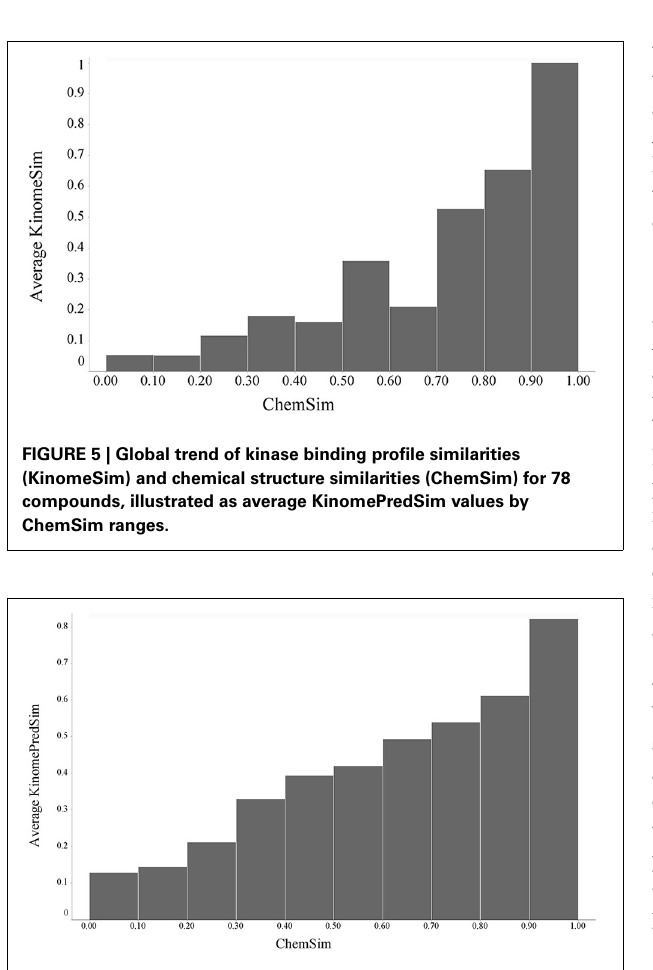
FIGURE 6 | Global trend of pairwise predicted kinase inhibition profile similarities (KinomePredSim) and chemical structure similarities (ChemSim) for 5364 compounds, illustrated as average KinomePredSim values by ChemSim